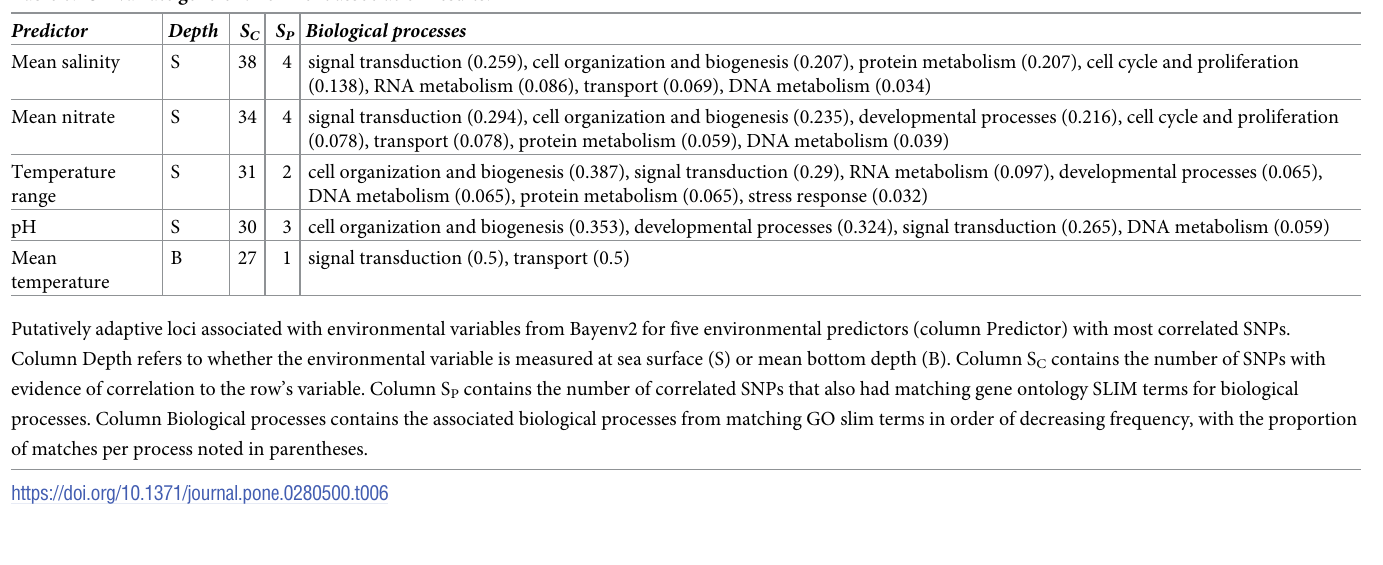
Table 6. Univariate gene-environment association